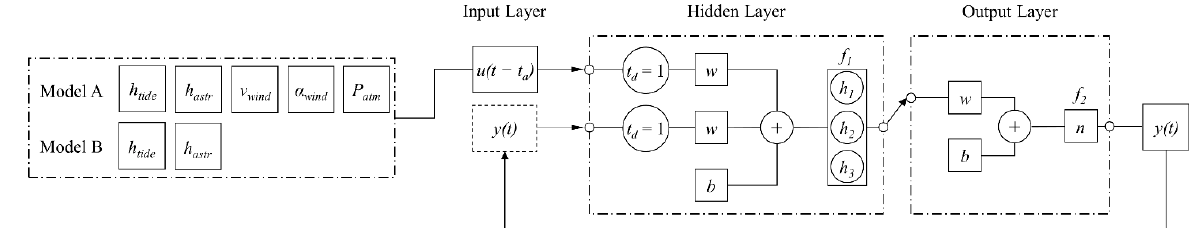
Figure 2. Sketch of the NARX model architecture.